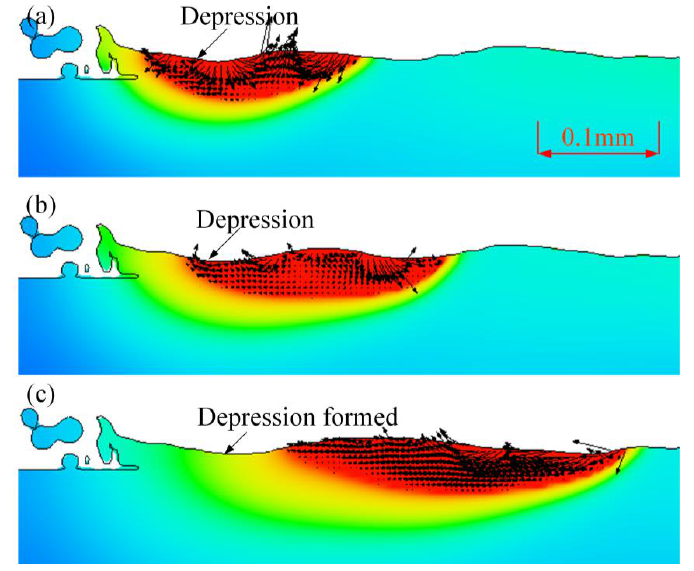
Figure 14. The cause diagram of the left end depression of the track when the ILP power is 130 W. ( a ) t = 1.30 ms; ( b ) t = 1.40 ms; ( c ) t = 1.60 ms. The parameters of SLM were 150 W, 0.8 m/s and 0.05 mm. The parameters of ILP were 130 W, 0.8 m/s and 0.05 mm. The entire domain is 0.54 mm long and 0.15 mm high.